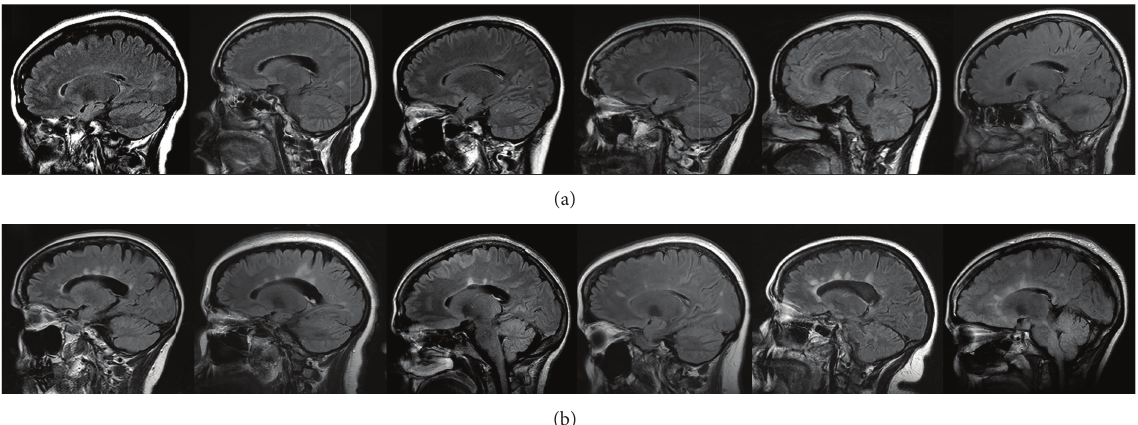
Figure 3: Evaluation of FLAIR sagittal images. Patients with NMO are shown in (a): Dawson’s fingers are absent. In contrast, most MS patients (b) demonstrate elongated, flame-shaped lesions oriented along the course of deep medullary veins, compatible with perivenous